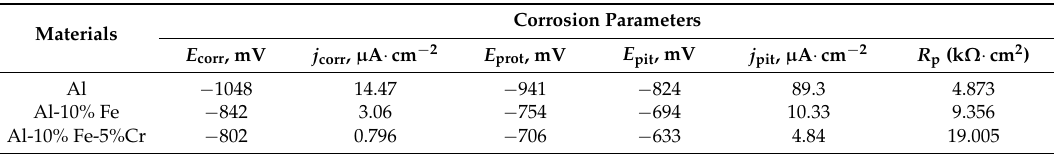
Table 1. Potentiodynamic polarization parameters of pure Al, Al-10% Fe and Al-10% Fe-5%Cr alloy in 3.5% NaCl at room temperature after 1 h immersion